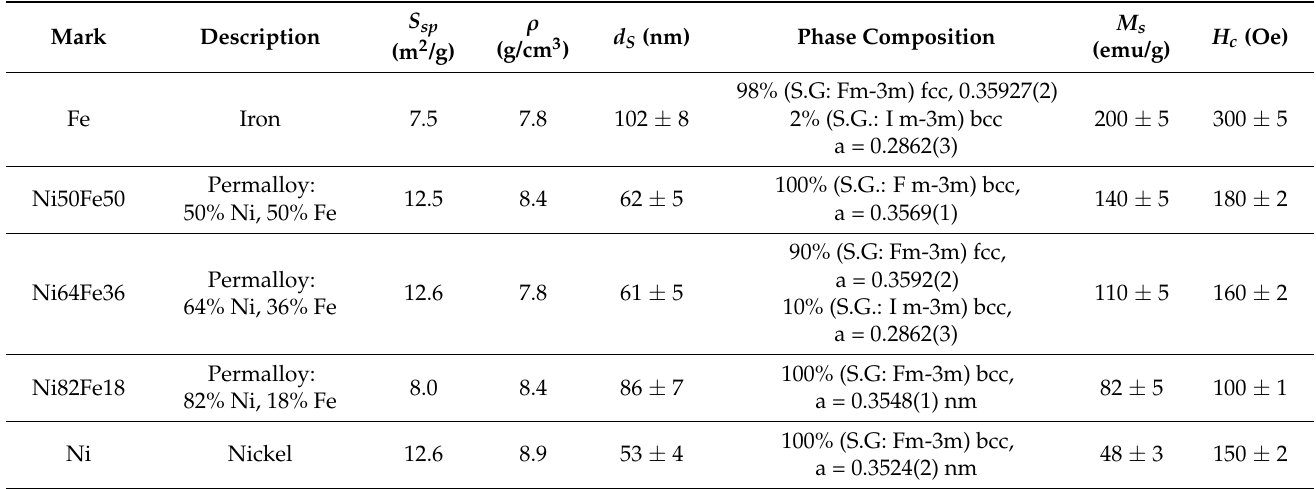
Table 1. Selected characteristics of EEW metallic nanoparticles: Specific surface area— S sp , density— ρ , apparent average diameter— d S , phase composition (all phases are cubic); saturation magnetization M s and coercivity H c measured for nanoparticles at 20 ◦ C.